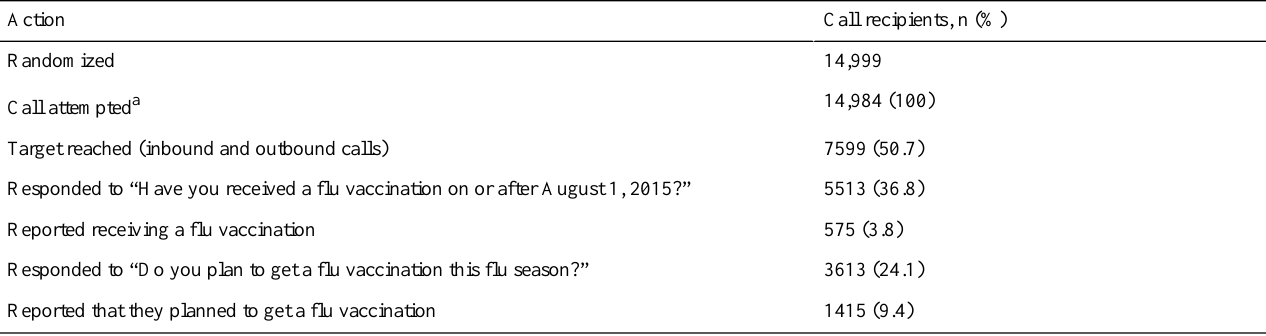
Table 4. Process measures and self-reported influenza vaccinations for interactive voice response call